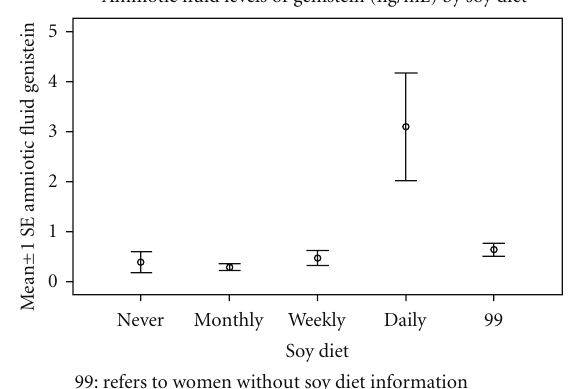
Figure 2: The amniotic fluid levels of Genistein (ng/mL) by soy diet.